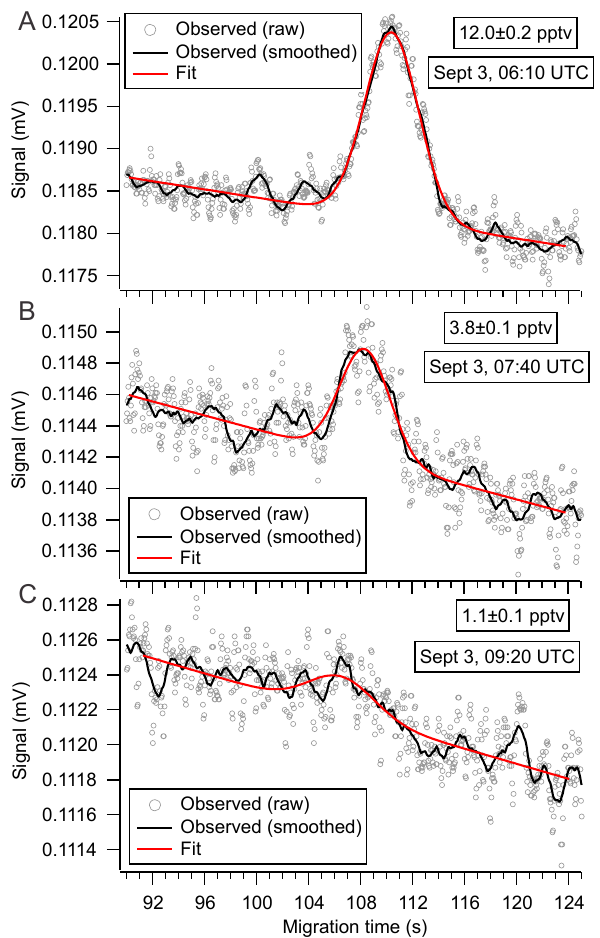
Figure 14. Chromatograms of PAN acquired on 3 September 2013. The fits to the peaks in (a) and (b) were unconstrained; the fit to the peak in (c) was constrained in its width parameter ( σ) to the earlier determined value (at a higher PAN concentration) of 2.1s. The mixing ratios are those of the peak area of the fitted line (shown in